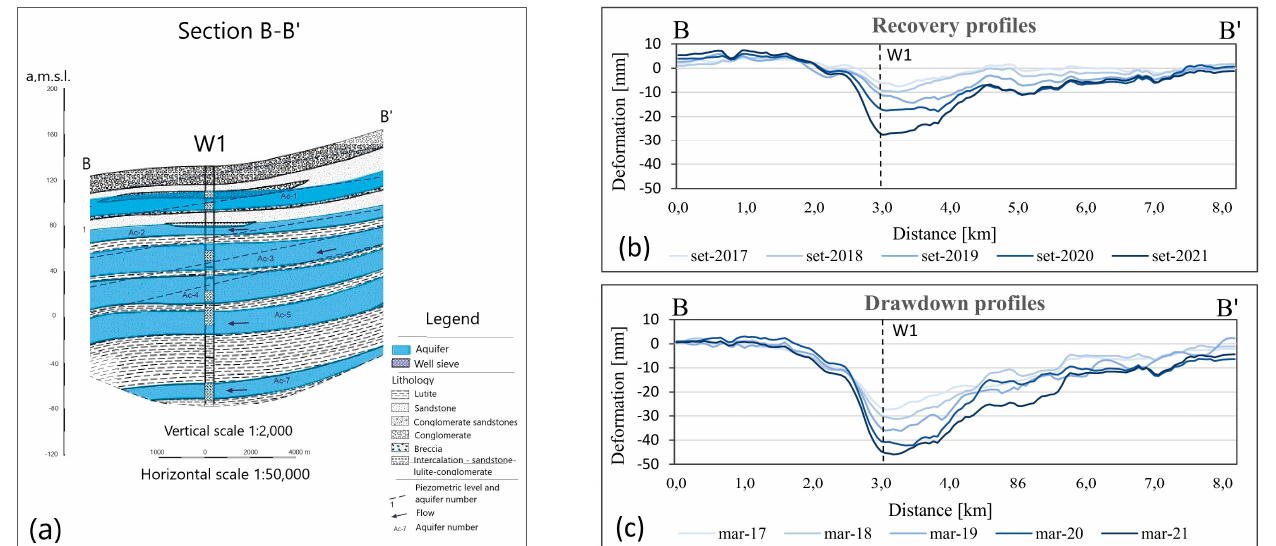
Figure 13. ( a ) Details Hydrogeological structure section B-B ′ and, ( b ) Deformation profiles recovery and, ( c ) Deformation profile drawdown.